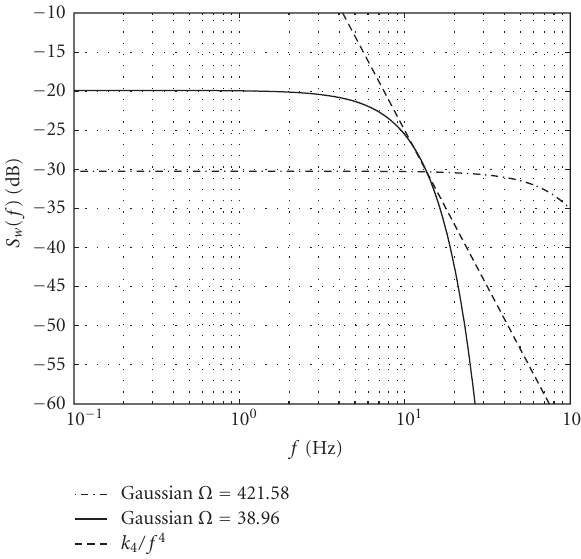
Figure 2: Gaussian regions with Ω = 421 . 58 and Ω = 38 . 96 along with the 31 . 62 / f 4